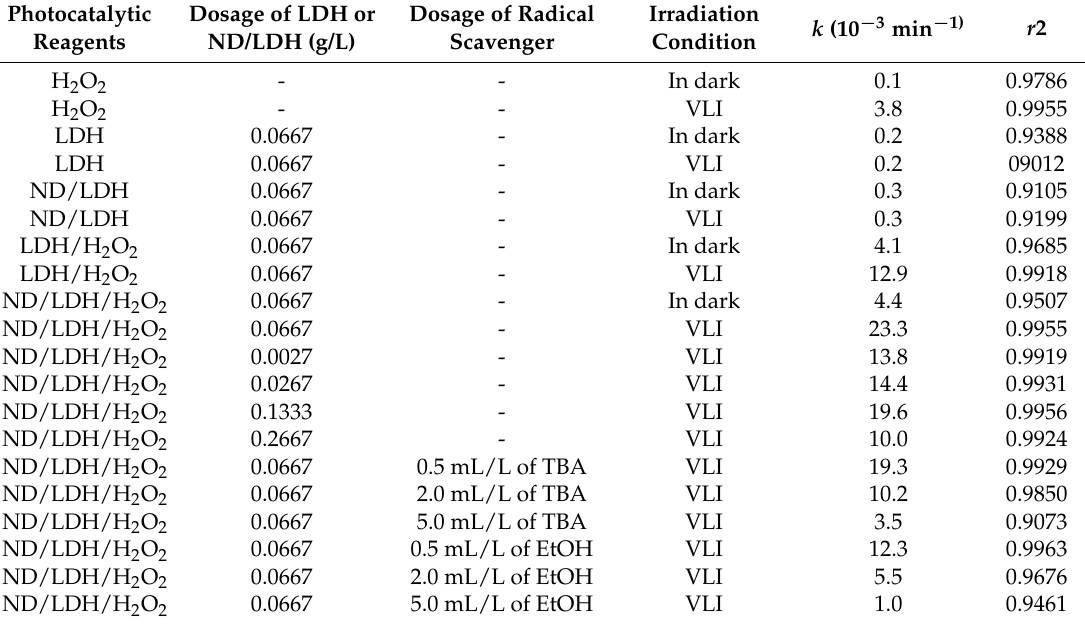
Figure 7. ( a ) Effect of ND/LDH dosage on MB removal under visible-light irradiation; and ( b ) pseudo-first-order kinetic fit for MB removal. (Error bars represent standard deviation of triplicate runs). Table 1. Pseudo-first-order rate constants ( k ) of MB degradation and respective regression coefficients ( r 2) in different reaction systems.